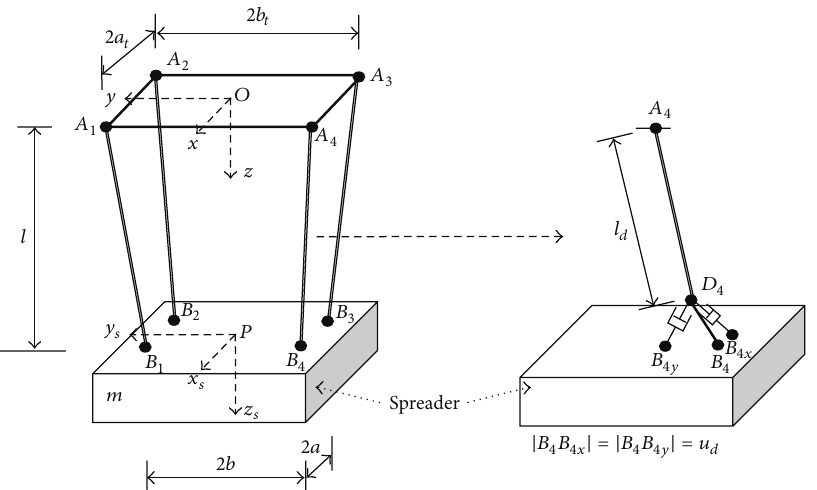
Figure 2: Geometry of the trolley, the spreader, the cables, and a typical cable-damper system connecting to a main cable in work.